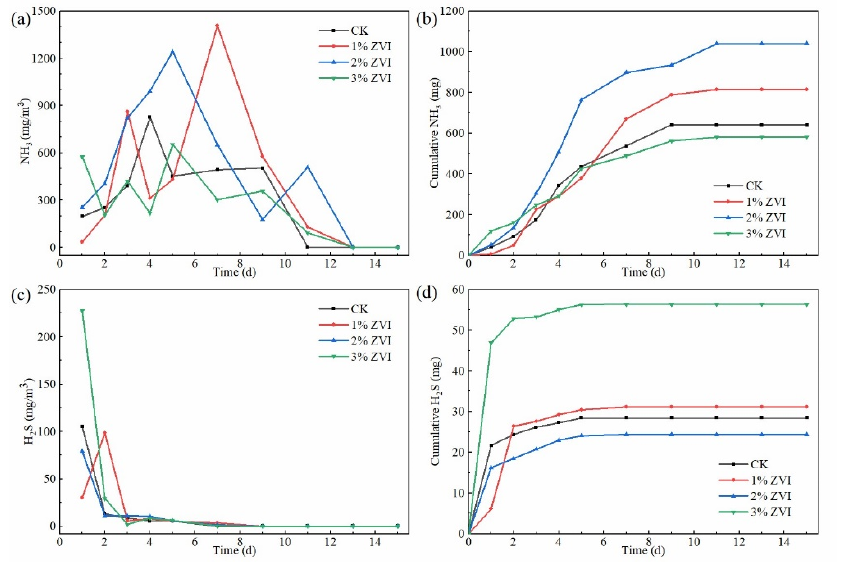
Figure 3. Dynamics of NH 3 ( a ) and H 2 S ( c ) emission and cumulative emission of NH 3 ( b ) and H 2 S ( d ) from the composting pile under different ZVI additions. ZVI: zero-valent iron. The cumulative amounts of NH 3 in the control group, as well as the groups with 1%, 2%, and 3% ZVI additions, were 641.5, 815.0, 1039.4, and 581.3 mg, respectively (Figure